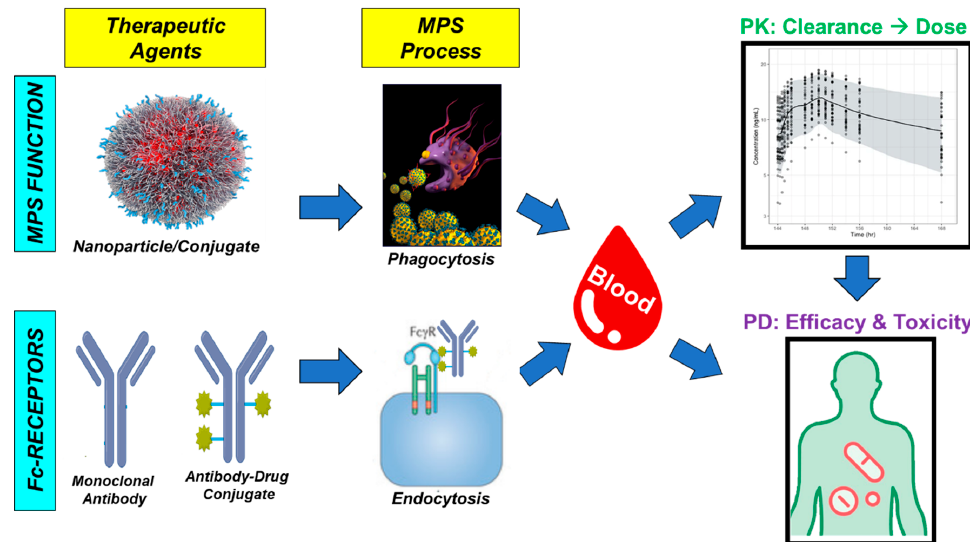
Figure 3. Clearance of nanoparticles (NPs) and mAb/ADC by MPS cells via phagocytosis and Fc ɣ R endocytosis, respectively, and the effects on PK blood/serum exposure, efficacy, and toxicity.